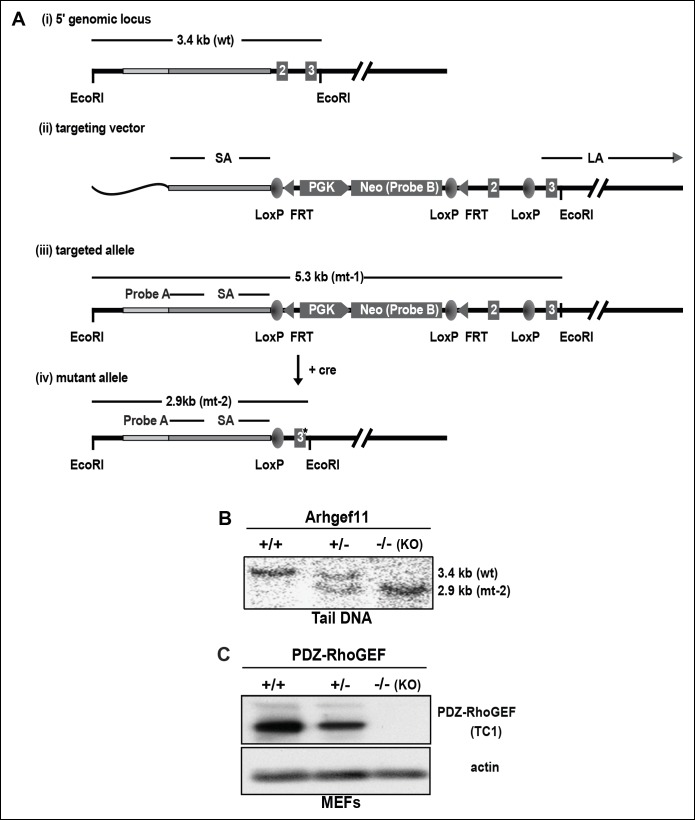
PDZ-RhoGEF gene targeting in the mouse.(A) PDZ-RhoGEF targeting strategy (i) The 5’ genomic region of PDZ-RhoGEF (wild-type, WT), (ii) the gene targeting vector, (iii) the targeted allele and (iv) the mutated allele (mt). Short arm (SA), long arm (LA), flanking probe (FP), neomycin (Neo), phosphoglycerol kinase promoter (PGK), cyclization recombinase (cre), flipase recognition target (FRT), and locus X over P1 (loxP), are indicated. (B) Southern blot analysis of gene deletion following genetic introduction of Cre recombinase. (C) Confirmation of PDZ-RhoGEF deletion by immunoblotting with anti-PDZ-RhoGEF antibody (TC1).